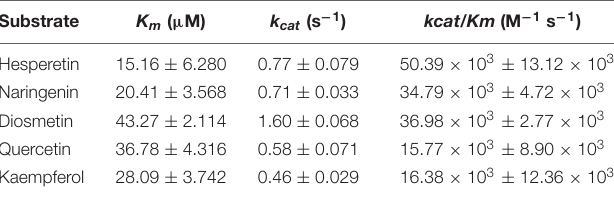
TABLE 1 | Kinetic parameters for the recombinant CsUGT76F1.